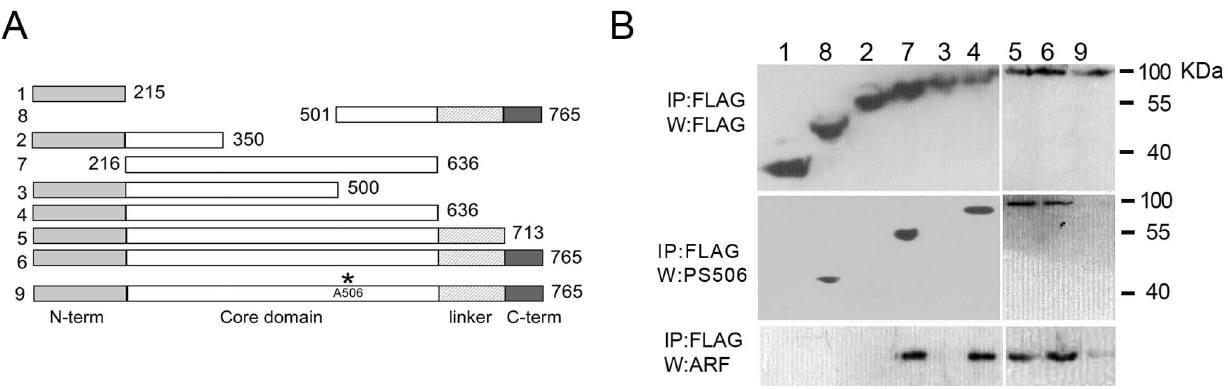
Figure 1. Identification of the ARF-interacting domain on topo I and the role of PS506 in ARF binding. (A) Scheme showing regions of the topo I protein encoded by the 9 expression constructs. The N-terminal domain, core domain, linker, and C-terminal domain are indicated. (B) Analysis of expression (top), PS506 content (middle), and ARF binding (bottom) of the products of constructs 1–9 expressed in human H358 lung cancer cells. Cells were treated with Adp14 (20 moi) to elevate cellular ARF levels. Lysates were collected 2 days after treatment and subjected to mouse anti-FLAG immunoprecipitation (IP) followed by Western (W) analysis with antibodies specific for FLAG (rabbit anti-FLAG), PS506, or ARF, as indicated.